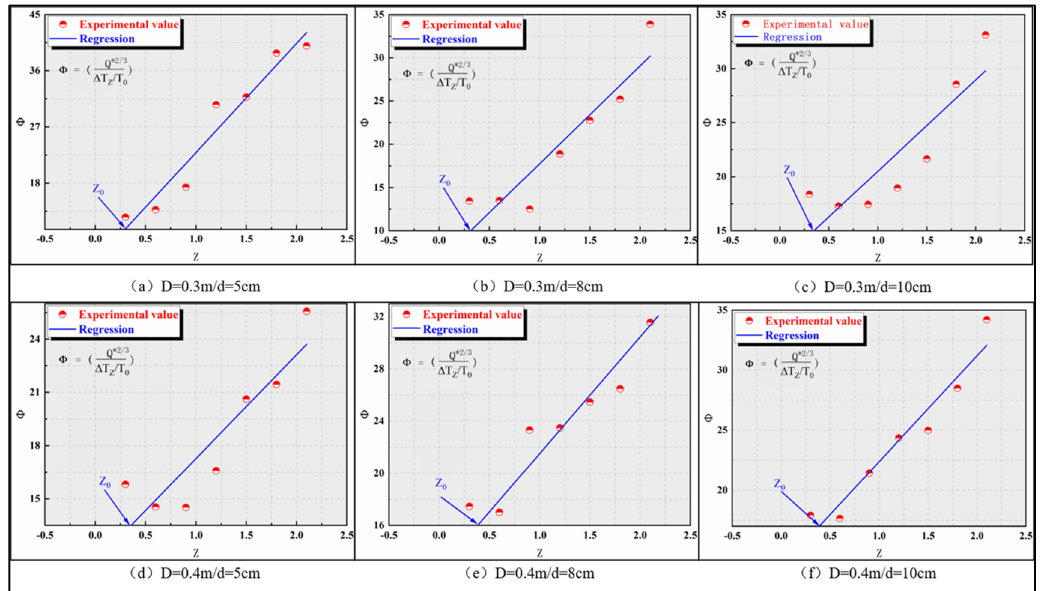
Figure 6. Location of virtual point source under various working conditions.